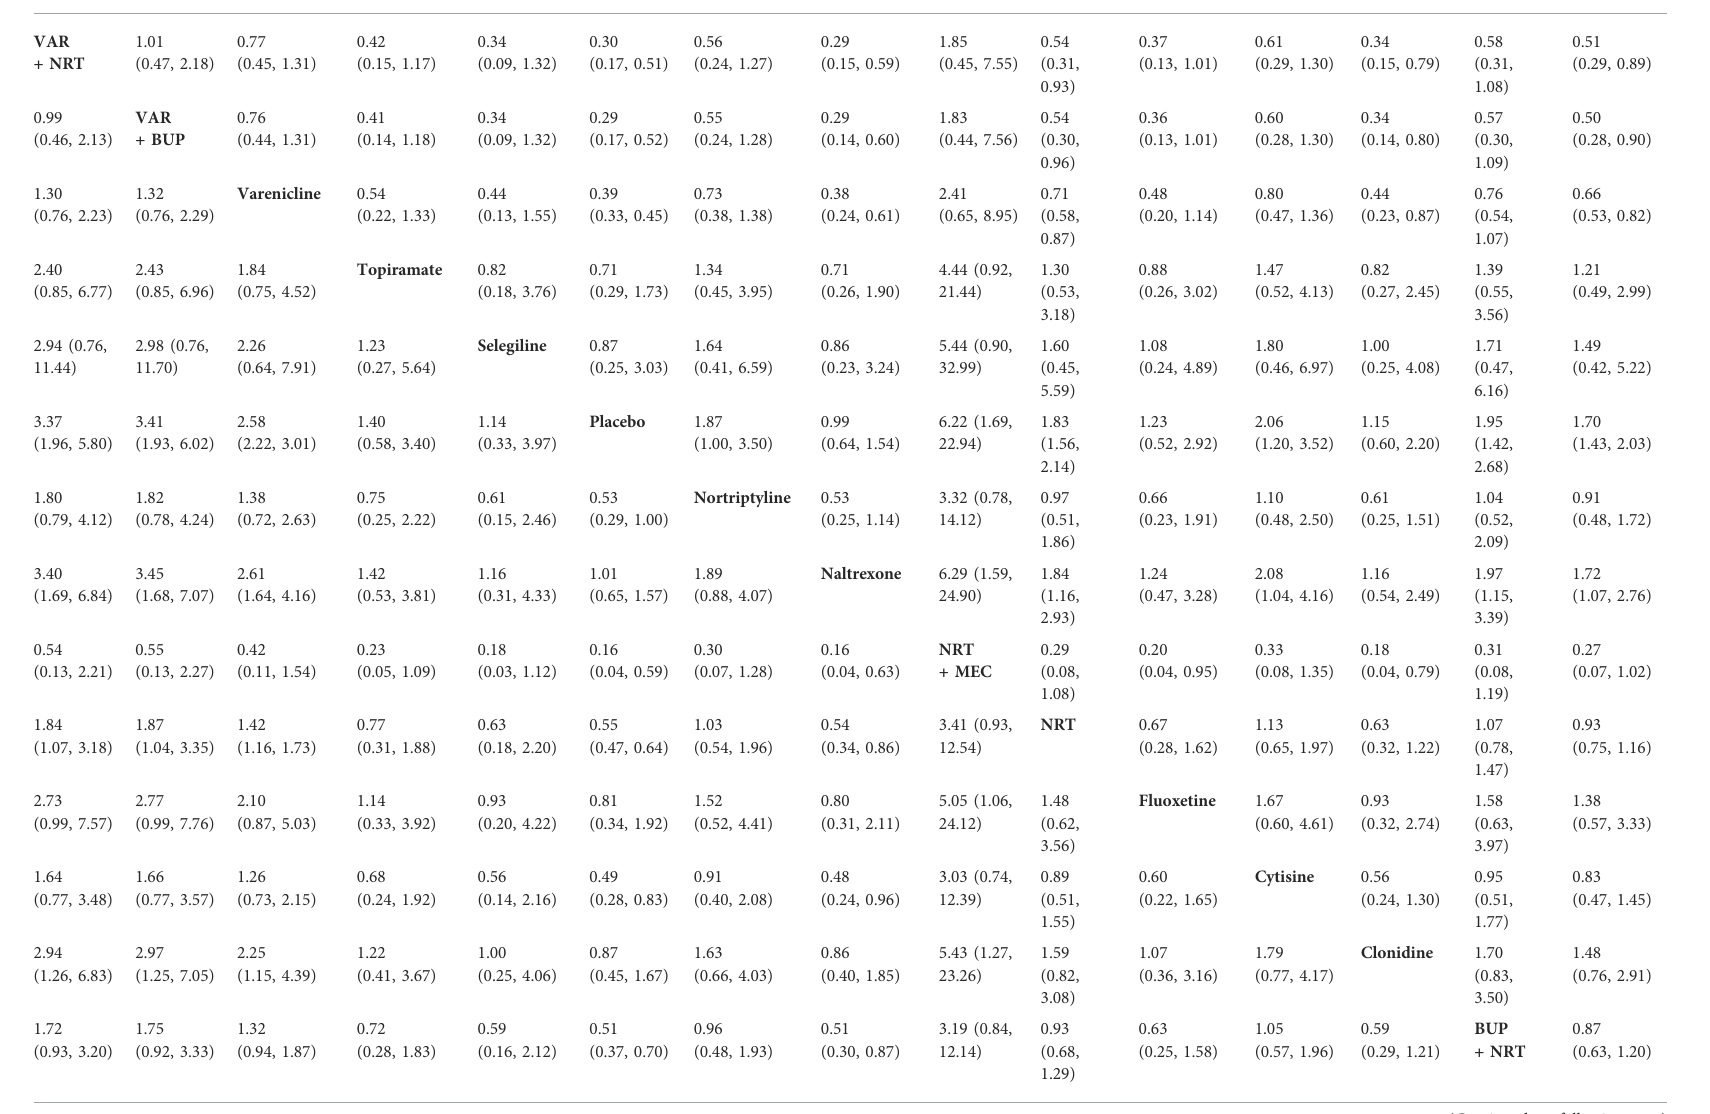
TABLE 2 The results of network meta-analysis for all pairwise comparisons. (A) Overall abstinence rate VAR +